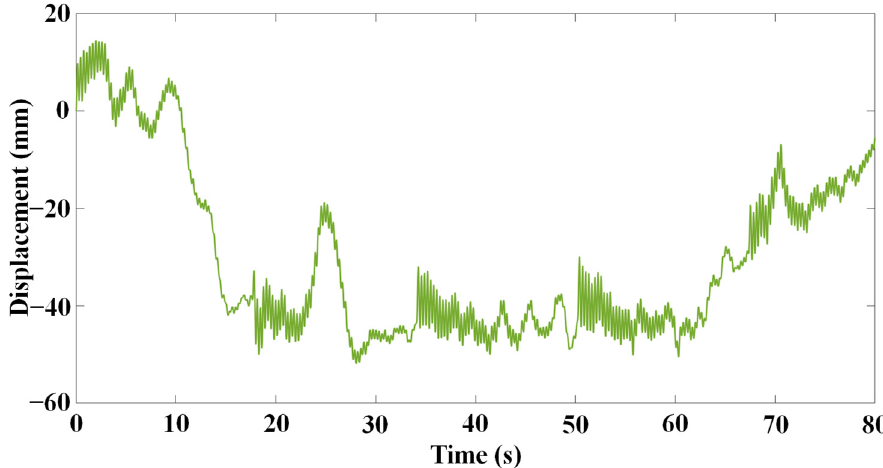
Figure 6. Displacement signal measured by the UAV.